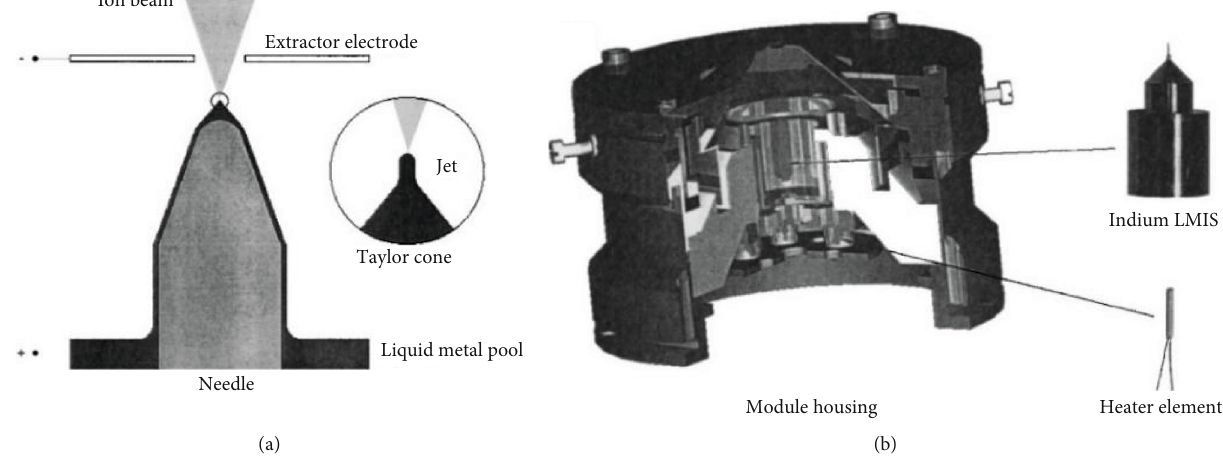
Figure 3: In-FEEP thruster: (a) in-FEEP principle; (b) in-FEEP thruster consisting of indium LMIS, heater element, and module housing [18].